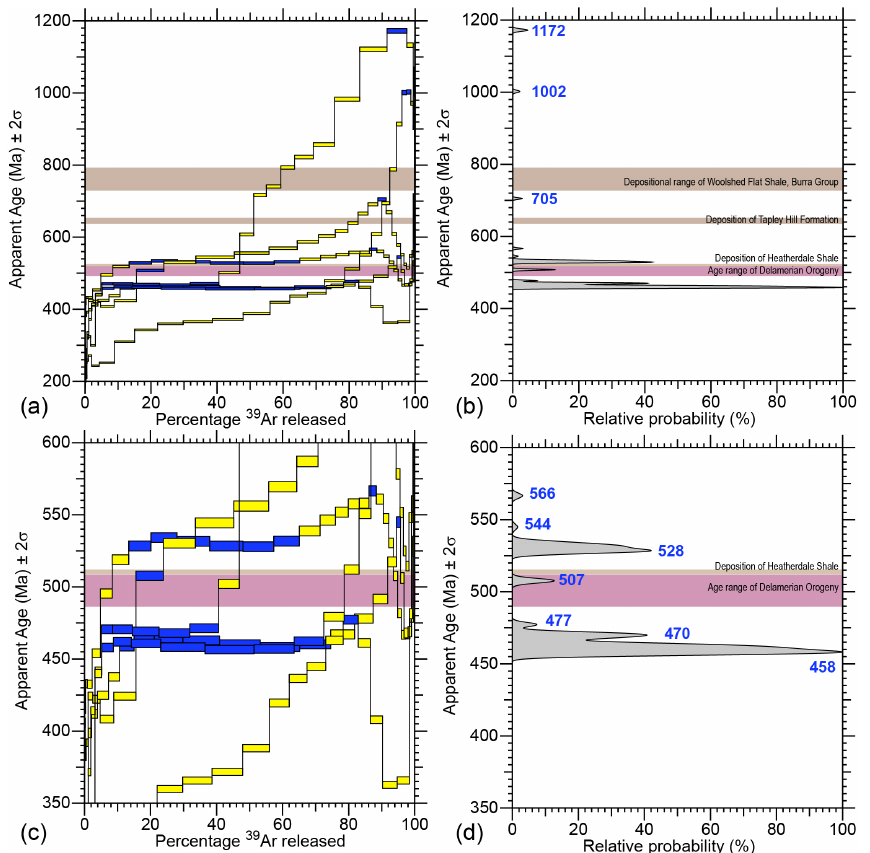
Figure 8. Synoptic plots that combine all age spectra and pooled Gaussian probability plots for the limits identified in each spectrum from this study. Steps highlighted in blue have either been combined into pooled ages or are given as age limits. Gaussian plots are calculated using the program eArgon and the methods described in detail by Muston et al. (2021). (a) Synoptic plot from 200 to 1200Ma. (b) Gaussian probability plot from 200 to 1200Ma. (c) Detailed synoptic plot from 350 to 600Ma. (d) Detailed Gaussian probability plot from 350 to